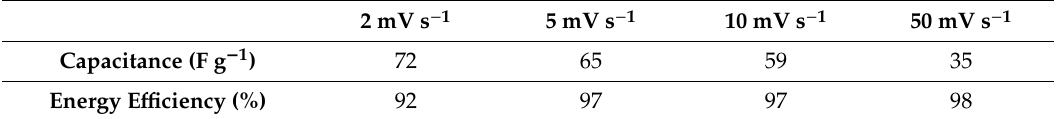
Figure 3. Two-electrode cell performance of hybrid cell 1 with 1 mol L − 1 NaI electrolyte: ( a ) CVs at 2 mV s − 1 (full line), 5 mV s − 1 (big dashed line), 10 mV s − 1 (small dashed line), and 50 mV s − 1 (dotted line) and ( b ) GCPL curves at 0.1 A g − 1 (full line), 0.25 A g − 1 (big dashed line), 0.5 A g − 1 (small dashed line), and 1.0 A g − 1 (dotted line). Table 1. Capacitance and energy efficiency values calculated from cyclic voltammograms at each scan rate for hybrid cell 1.